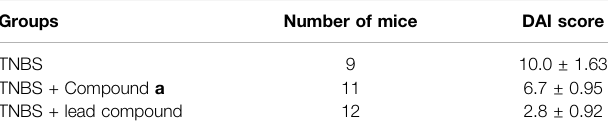
TABLE 5 | DAI score results of mice in each group.